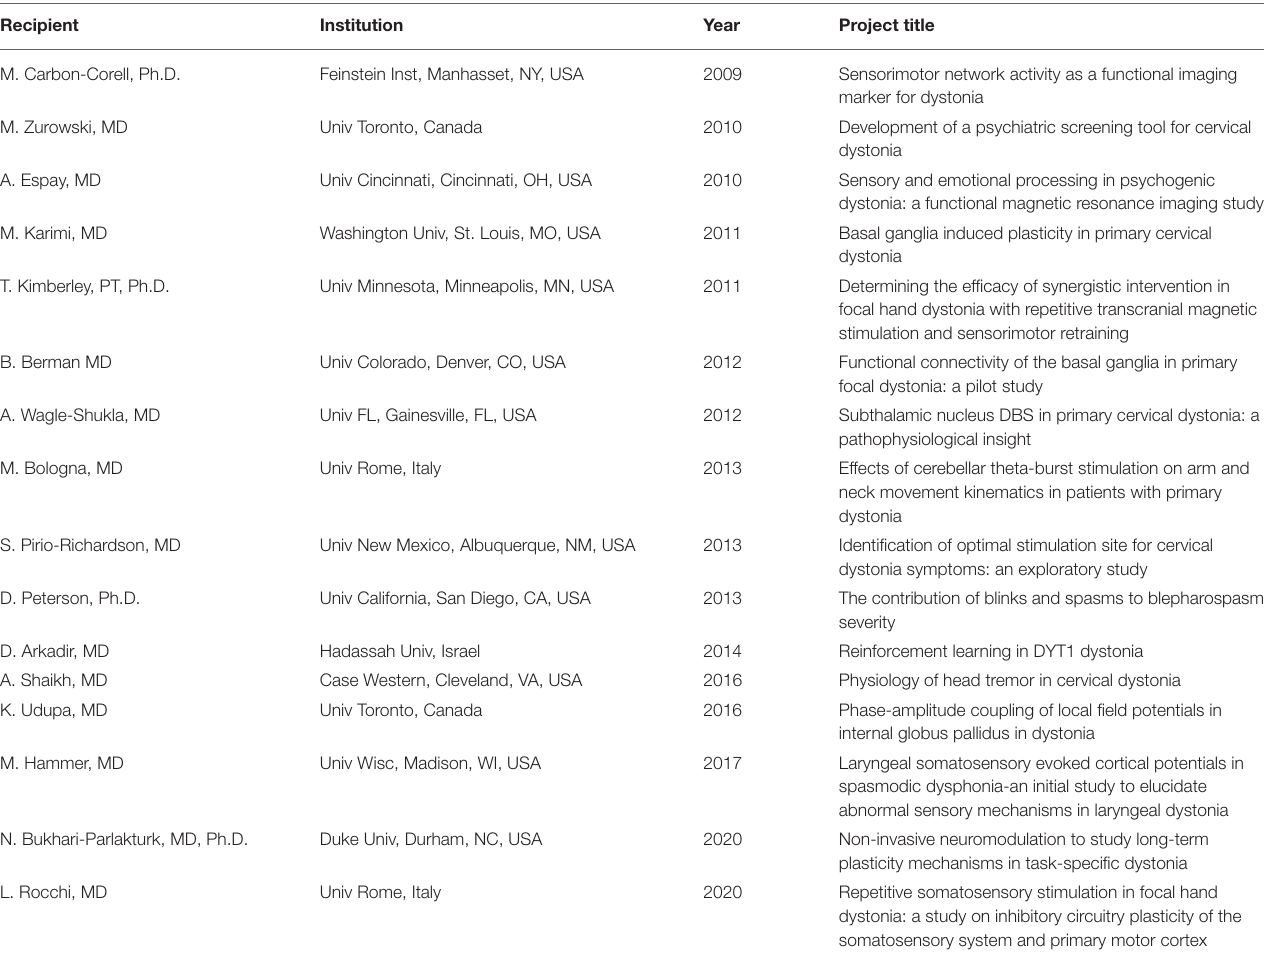
TABLE 3 | Dystonia Coalition career development award program